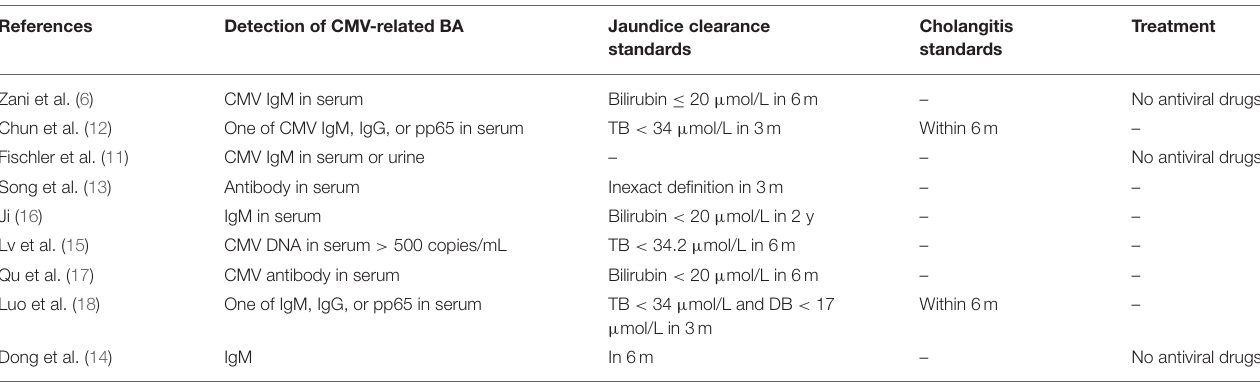
TABLE 2 | Data from the reports included in the